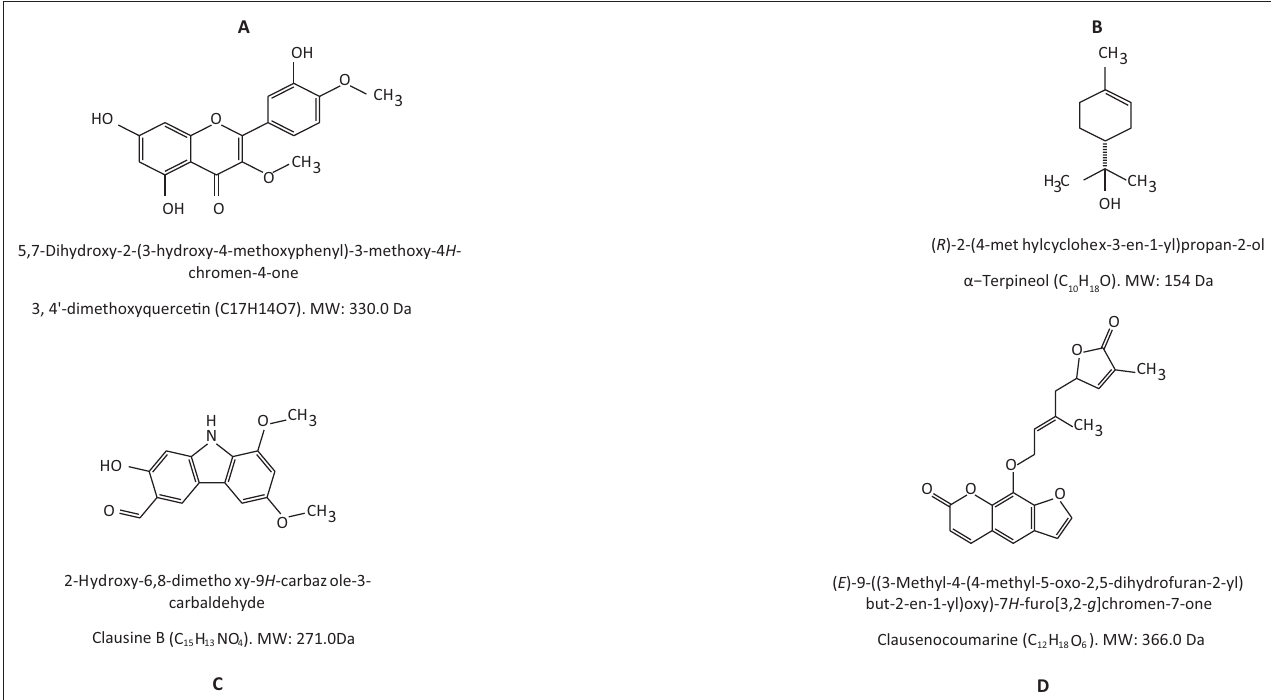
Clausine B 15 H 13 NO 4 ). MW: 271.0Da(C